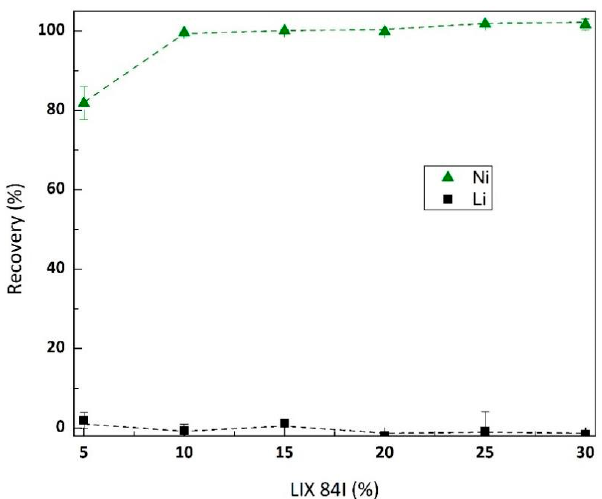
Figure 8. Effect of LIX ® 84-I concentration ( v/v ) on Ni and Li extraction from raffinate (pH 5, metal concentration in feed Ni 0.13 g/L and Li 0.55 g/L).